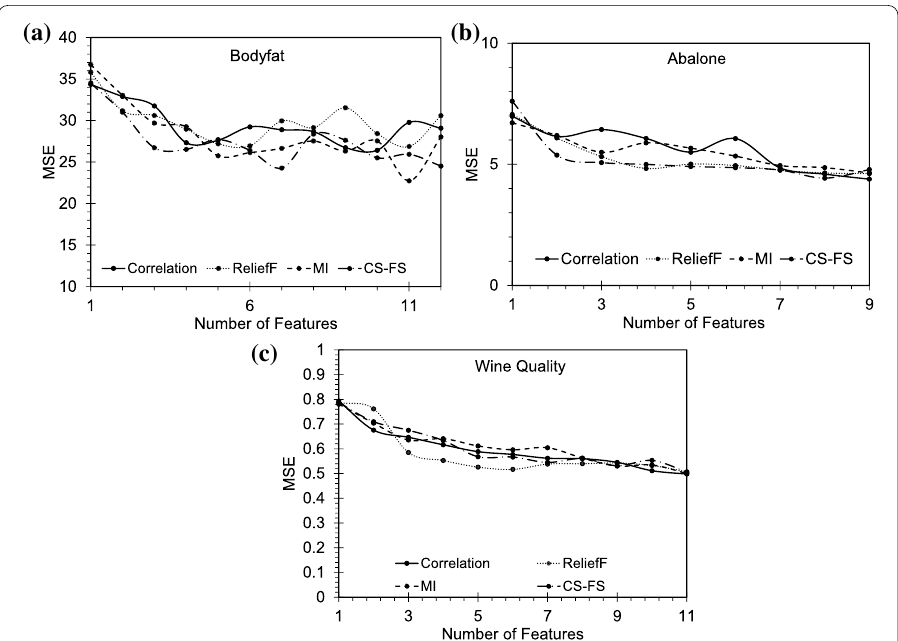
Fig. 3 Comparison of the complex-step sensitivity method with other feature selection methods for regression